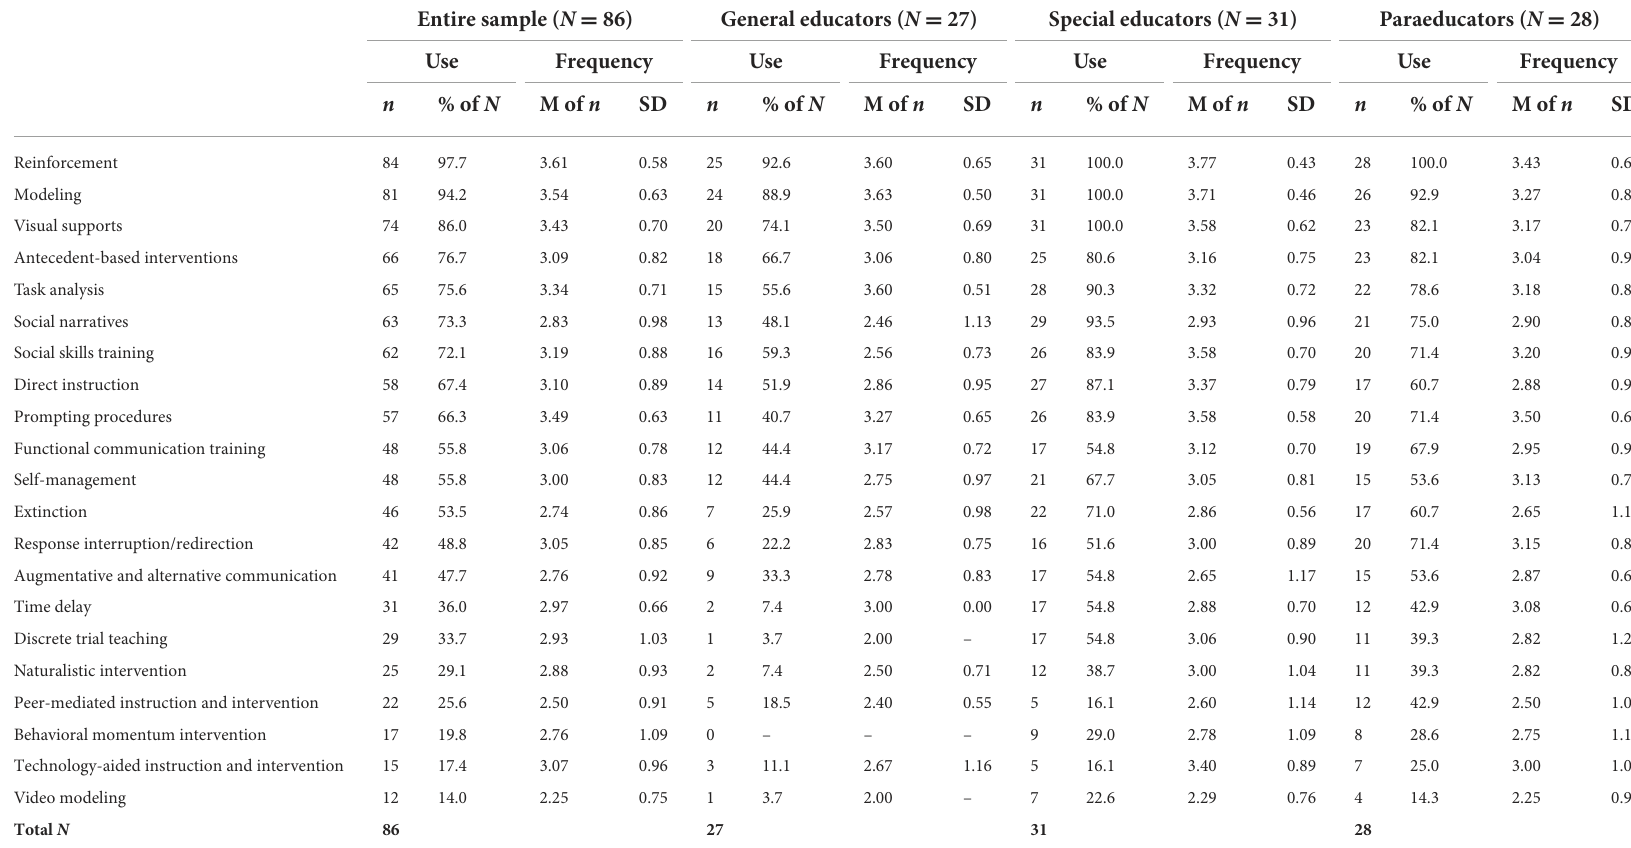
TABLE 4 Multicomponent practice and strategies use (ranked by entire